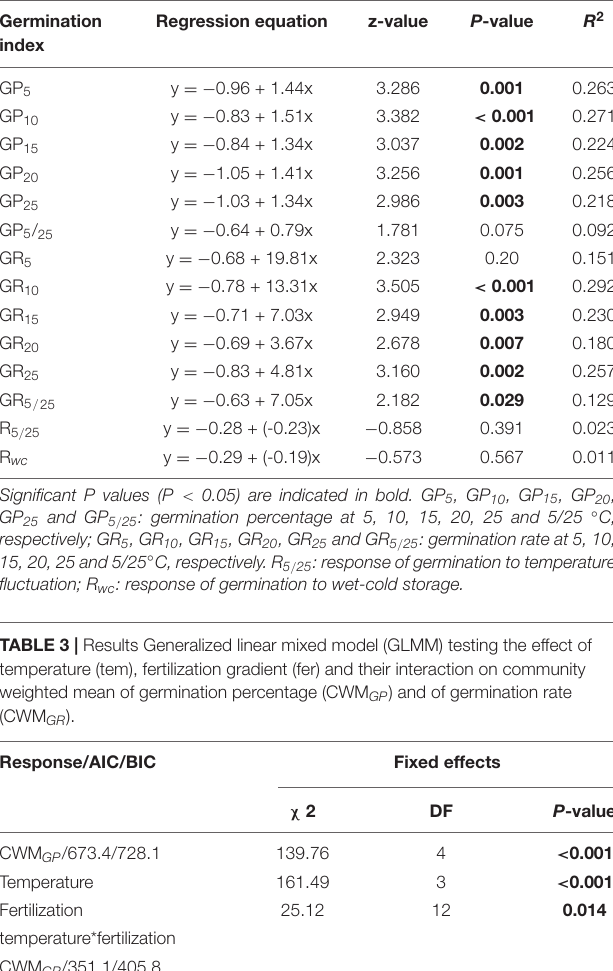
TABLE 2 | Results of Beta regression models testing correlations of response of species abundance to fertilization (R f ) with germination percentage, germination rate (speed) and response of germination percentage to temperature fluctuation and wet-cold storage.